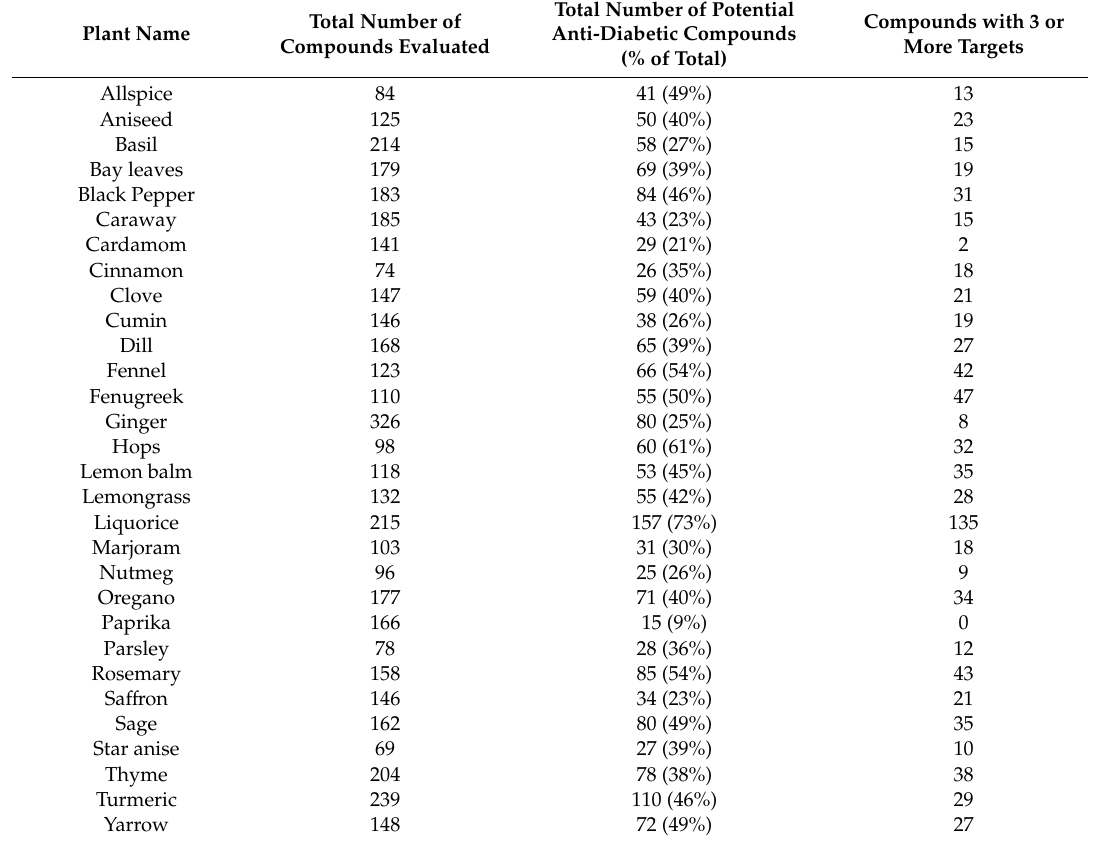
Table 2. Summary of DIA-DB inverse virtual screening results for various herbs and